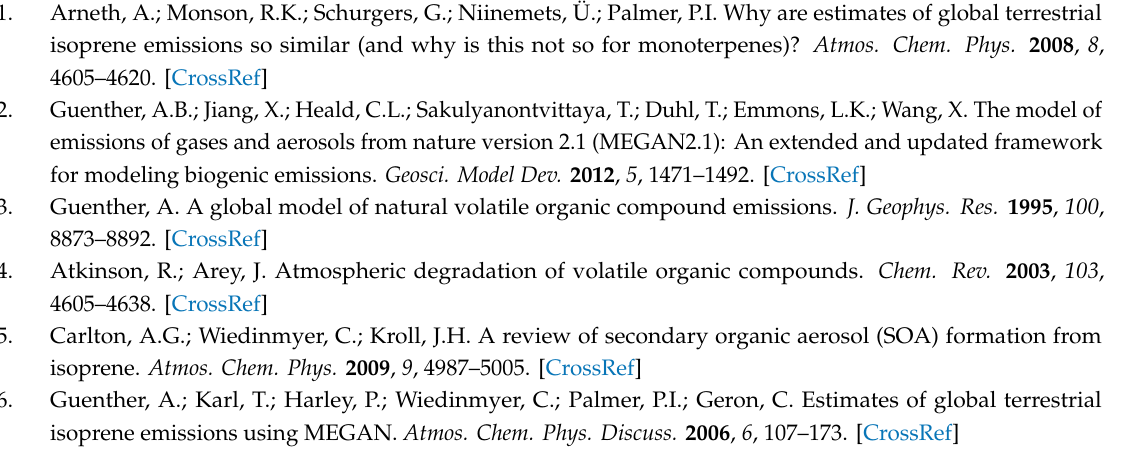
Figure S1: Isoprene consumption in microcosms from oil palm leaf (OPL) washings and swabs. Figure S2: Isoprene consumption in microcosms used in DNA-SIP experiments with oil palm soil (A) and leaf washings (B). Figure S3: Separation 12 C and 13 C DNA of oil palm soil (A) and oil palm leaf washings (B) throughout the DNA-SIP experiments. Figure S4: Relative abundance of bacterial orders during DNA-SIP enrichments. Figure S5: 16S rRNA gene phylogenetic tree of representative members of the Gordonia genus and the oil palm leaf isolate Gordonia strain OPL2. Figure S6: 16S rRNA gene phylogenetic tree of representative members of the Sphingomonadaceae family and the oil palm leaf isolate Sphingopyxis sp. OPL5. Figure S7: Growth of Sphingopyxis sp. OPL5 in a 4-liter fermenter with isoprene. Figure S8: Rate of oxygen uptake (V 0 ) as a function of isoprene concentration [S 0 ]. Table S1: Incorporation of 13 C-labelled carbon during DNA-SIP experiments with oil palm soil and leaf washings. Table S2: Identity of Iso polypeptides encoded by iso gene clusters when compared to the corresponding Iso polypeptides from Rhodococcus sp. strain